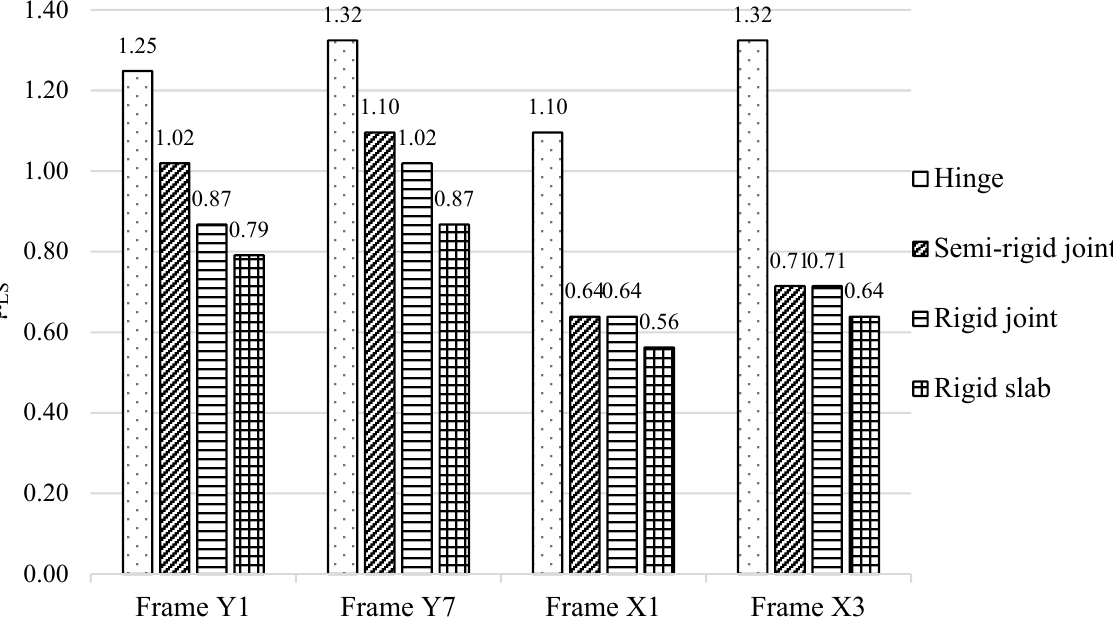
Figure 20. Damage factors of the warehouse with different connection types at the LS limit state.